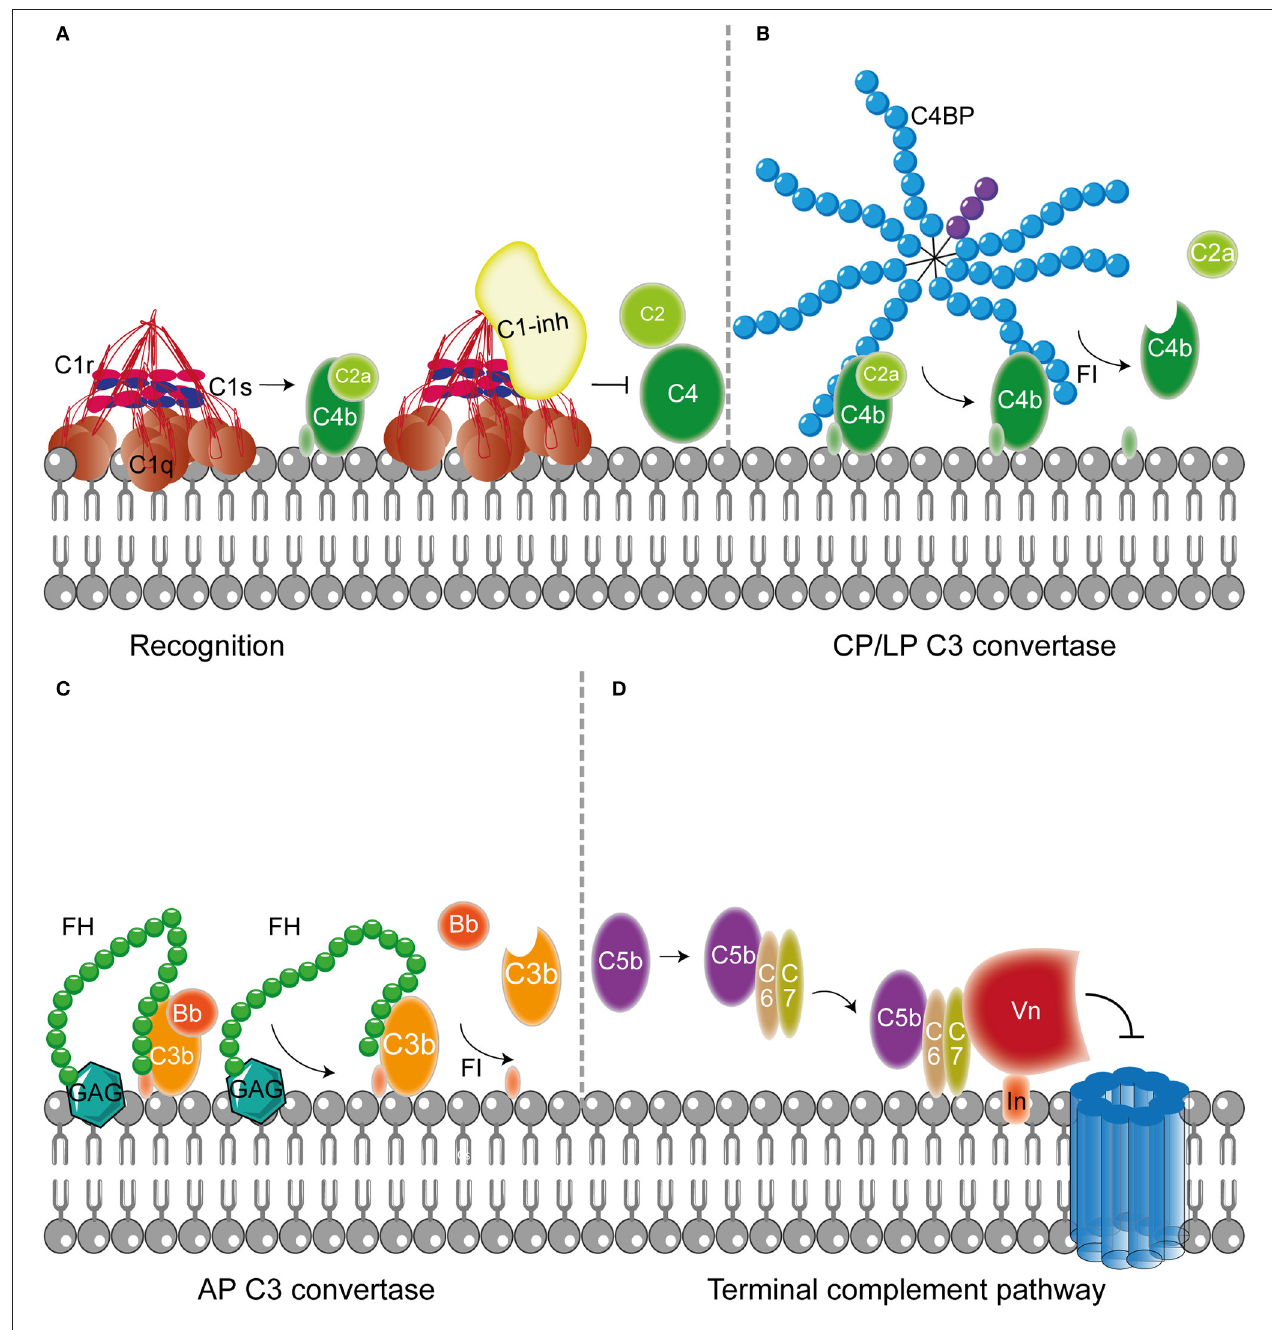
FIGURE 2 | Host fluid phase complement regulatory proteins. (A) Fluid regulatory protein C1-inh prevents complement activation by binding to C1s and C1r (and MASP-1 and MASP-2, not depicted here) preventing the cleavage of C4 and C2 and hence the formation of the CP and LP C3 convertase. (B) C4BP binding